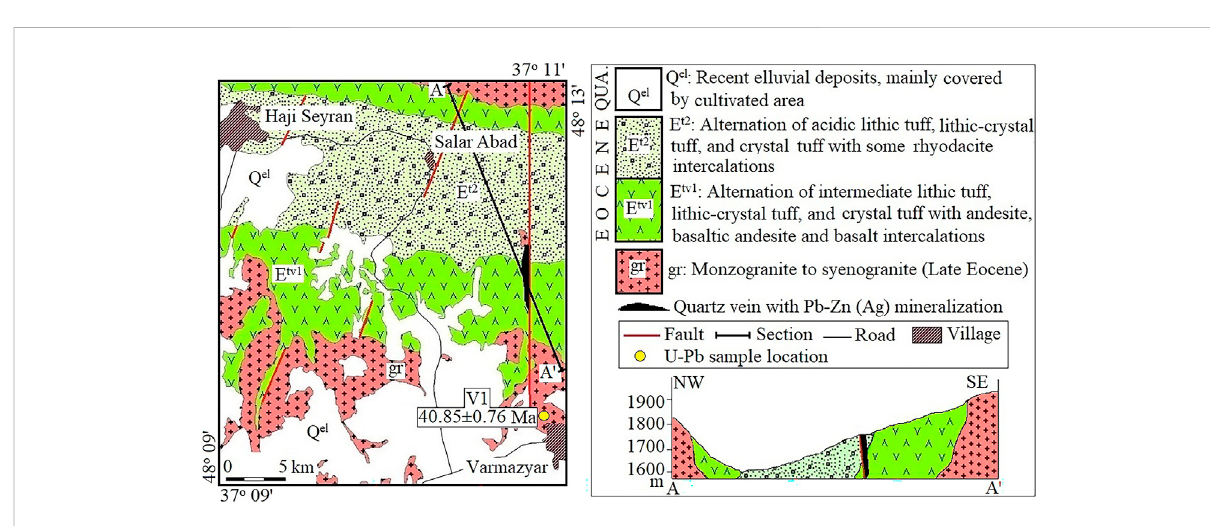
FIGURE 5 Geological map of the Varmazyar Pb – Zn (Ag) deposit (modi fi ed after Ghorbani et al.,